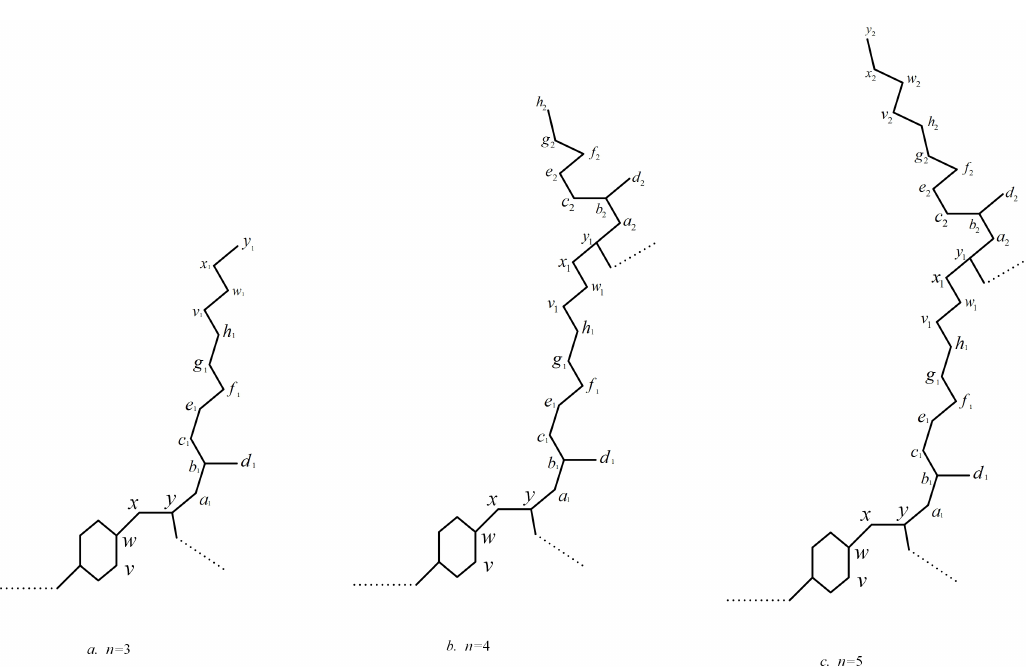
Fig. 4 One branch of D [ 3 ] , D [ 4 ] and D [ 5